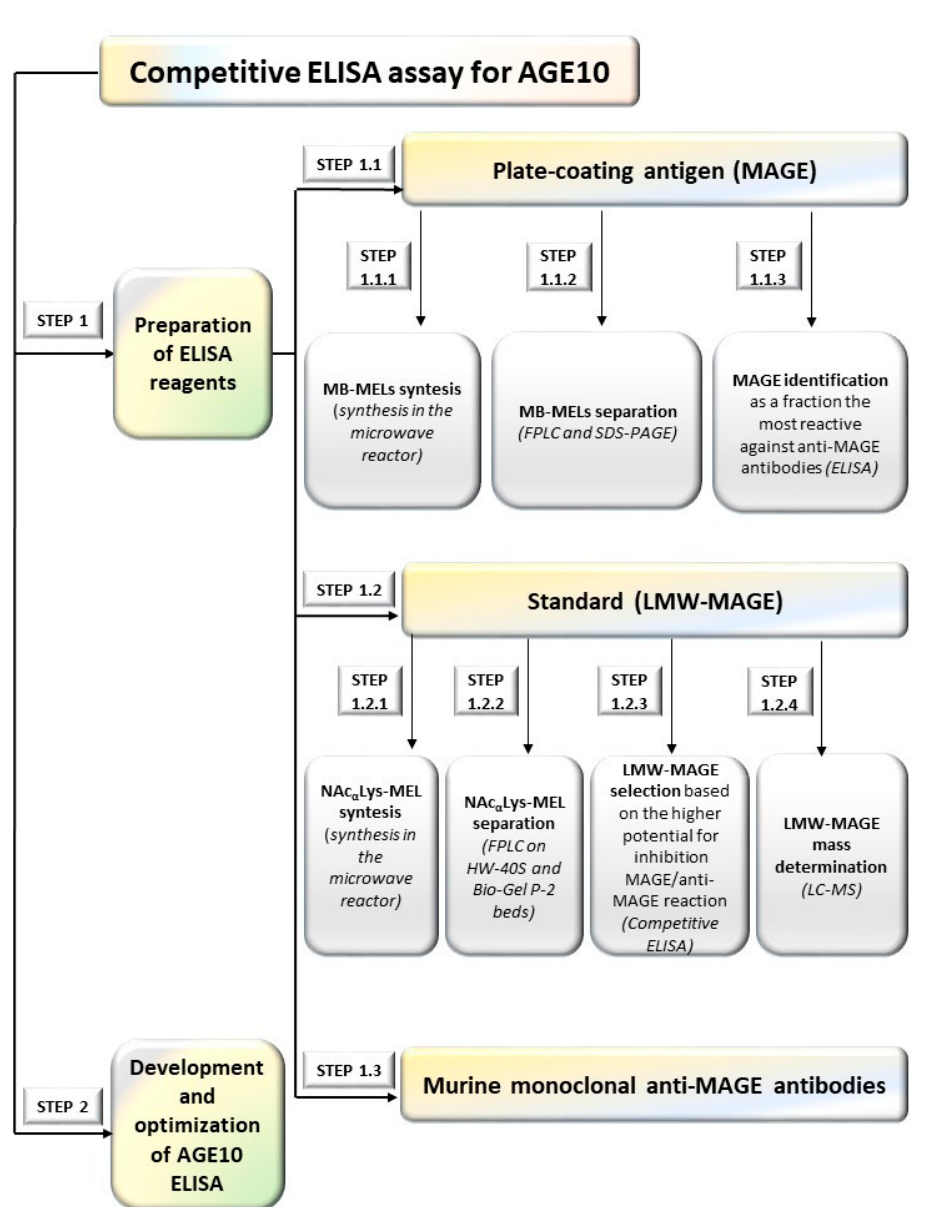
Figure 1. An overview of a process of AGE10 ELISA development; FPLC—the fast protein liquid chromatography, LC-MS—liquid chromatography mass spectrometer, LMW-MAGE—low molecular mass MAGE, MAGE—melibiose-derived AGE, MB-MELs—products of reaction of myoglobin with melibiose, NAc α Lys-MEL—products of reaction of N α -acetyllysine with melibiose.